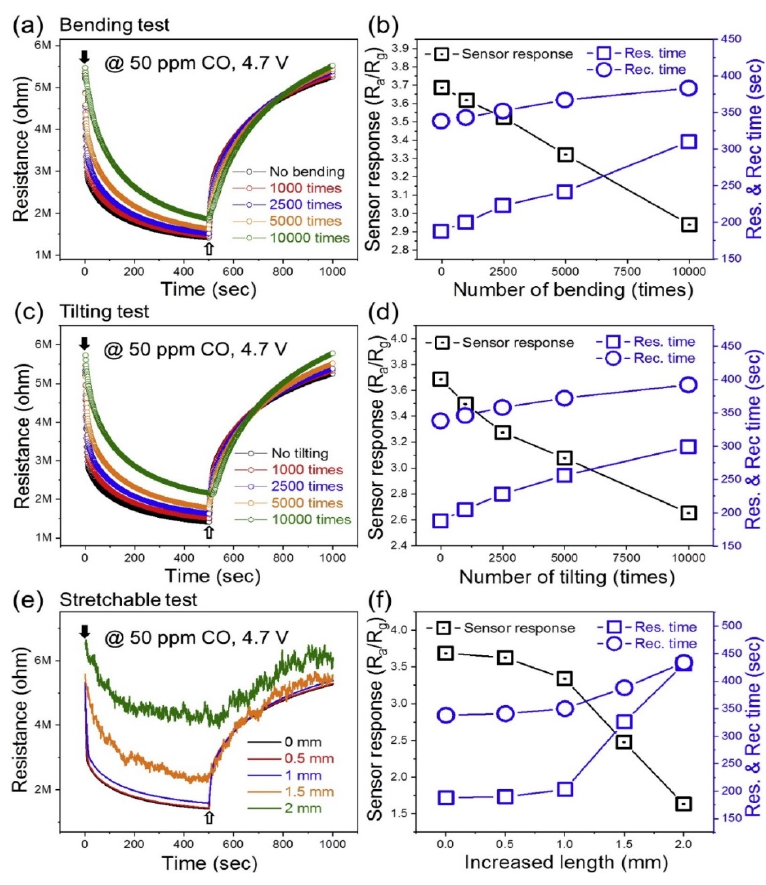
Figure 32. ( a ) Resistance plot of Au-SnO 2 co-decorated WS 2 sensor for response to 50ppm CO gas upon 10,000 bending cycles. ( b ) Corresponding response of the sensor and response/recovery times upon variation in the number of bending cycles. ( c ) Resistance plot of the sensor based on Au-SnO 2 co-decorated WS 2 NS upon exposure to 50ppm CO gas with different tilting cycles. ( d ) Corresponding response of the sensor and response/recovery time as a function of a change in the number of tilting cycles. ( e ) Resistance plots of the Au-SnO 2 co-decorated WS 2 sensor considering its response to 50ppm CO gas with variation of the stretching amount. ( f ) Equivalent sensor parameters as a function of increased length. All the sensing tests were performed at room temperature (24 ◦ C). Reproduced from [109] with the permission of